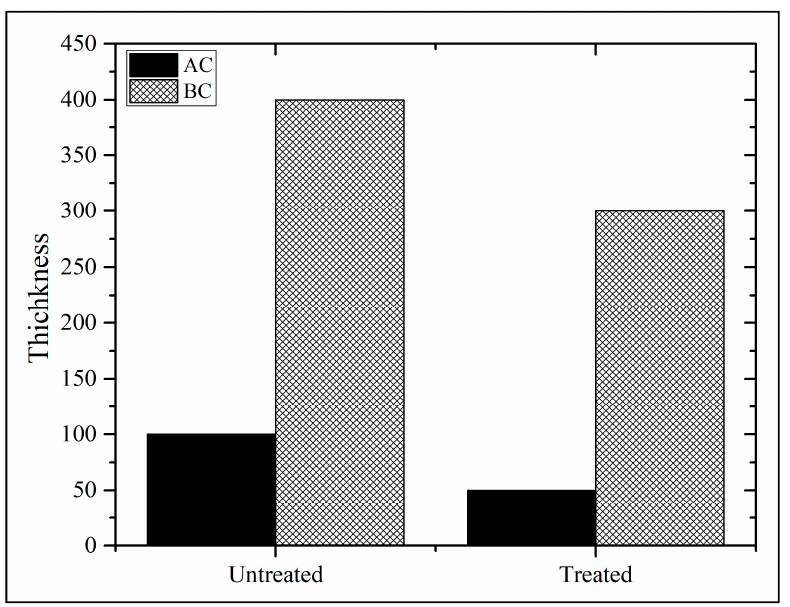
Figure 9. Comparative structural analysis (100%; 0%) on top of figure vs. (30%:70%) and 7% FA + 5% Figure 9. Thickness saving in pavement layers for untreated and treated base. OPC at bottom of